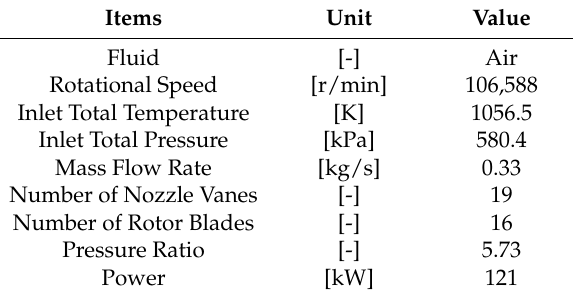
Table 1. Design parameters of T-100